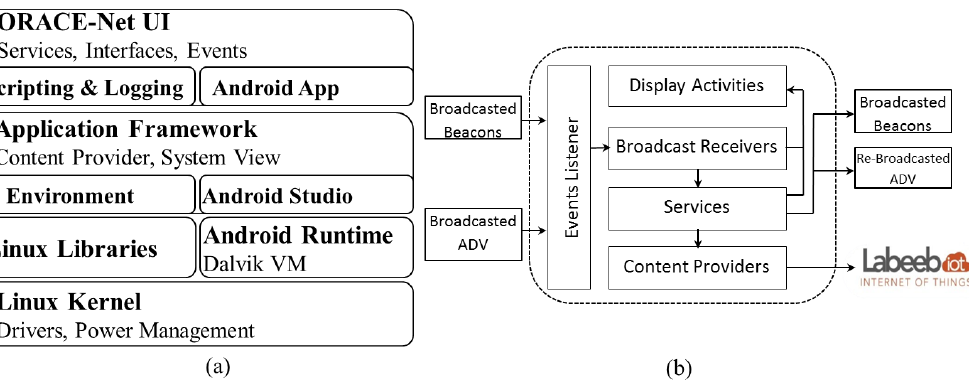
Figure 6. ( a ) ORACE-Net system-oriented stack over Linux and Android. ( b ) ORACE-Net Android application